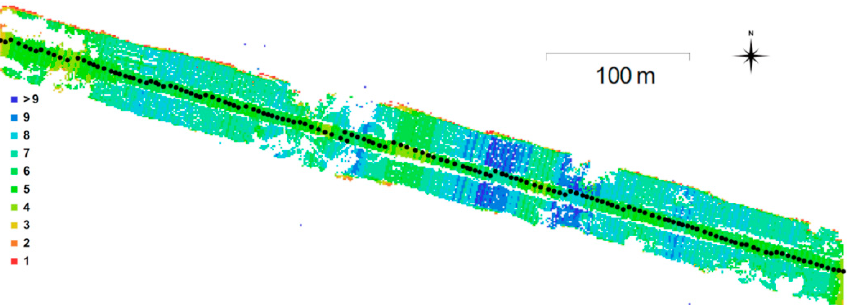
Figure 2. The camera locations (black dots) and the colour-coded image overlap of the Phantom4 strip flown at 30 m height with respect to the riverbed.